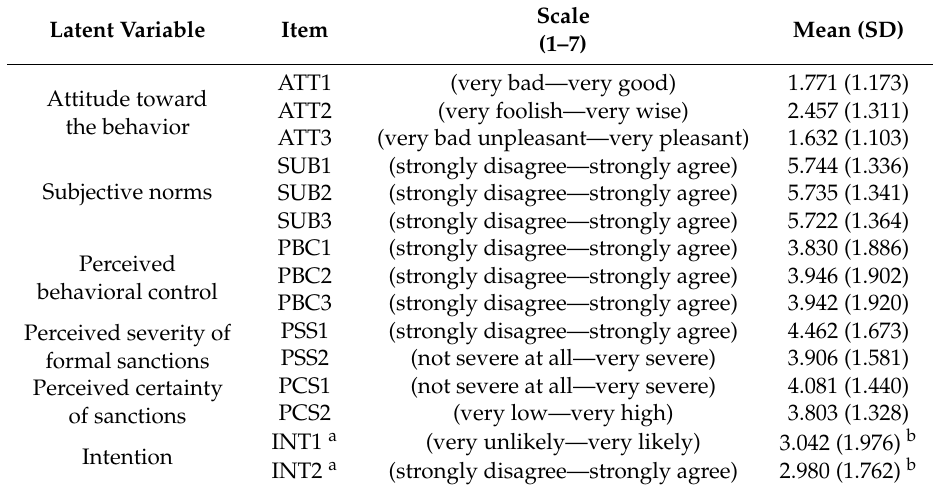
Table 5. The scale values and statistics of the measurement items in the survey